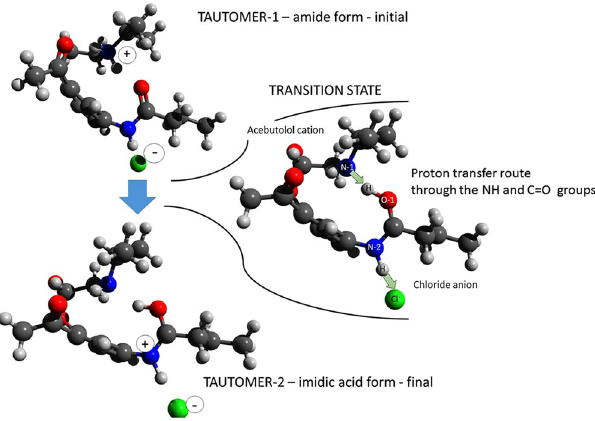
Figure 4. Proton transport mechanism in